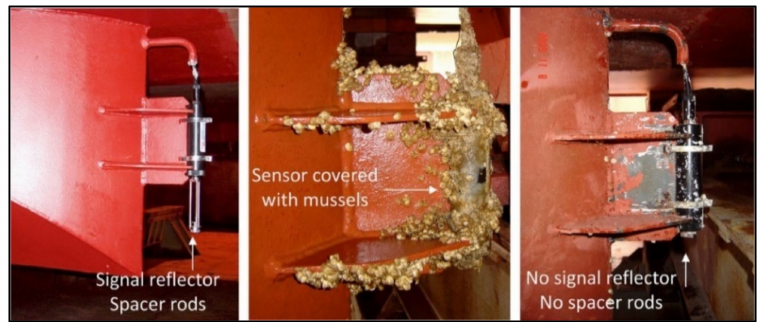
Figure 11. Technical condition of the sound velocity sensor after 2 years of operation.